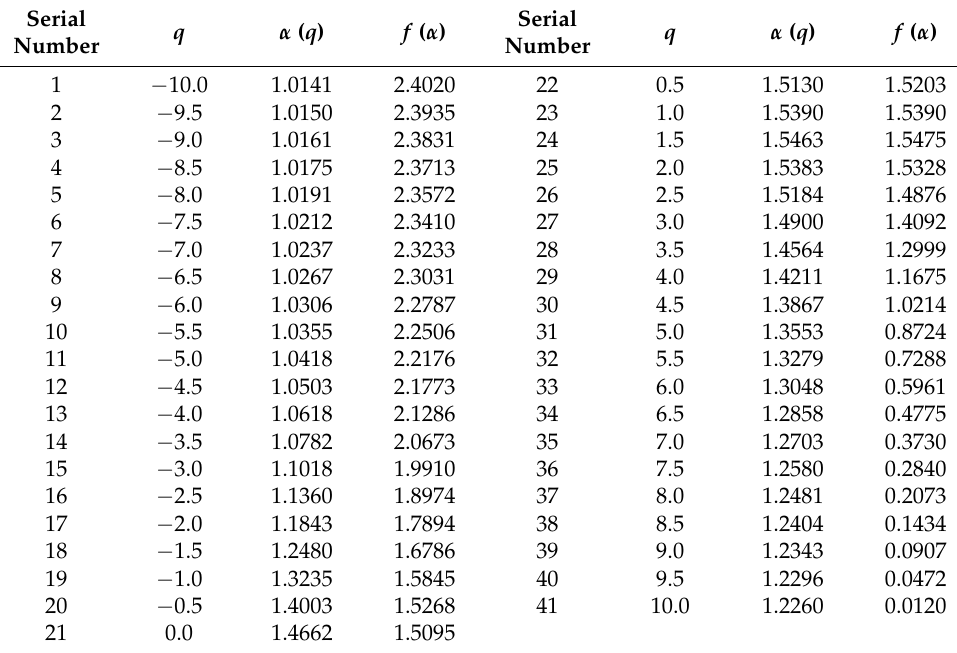
Table 8. Fault multifractal spectrum data table for the study